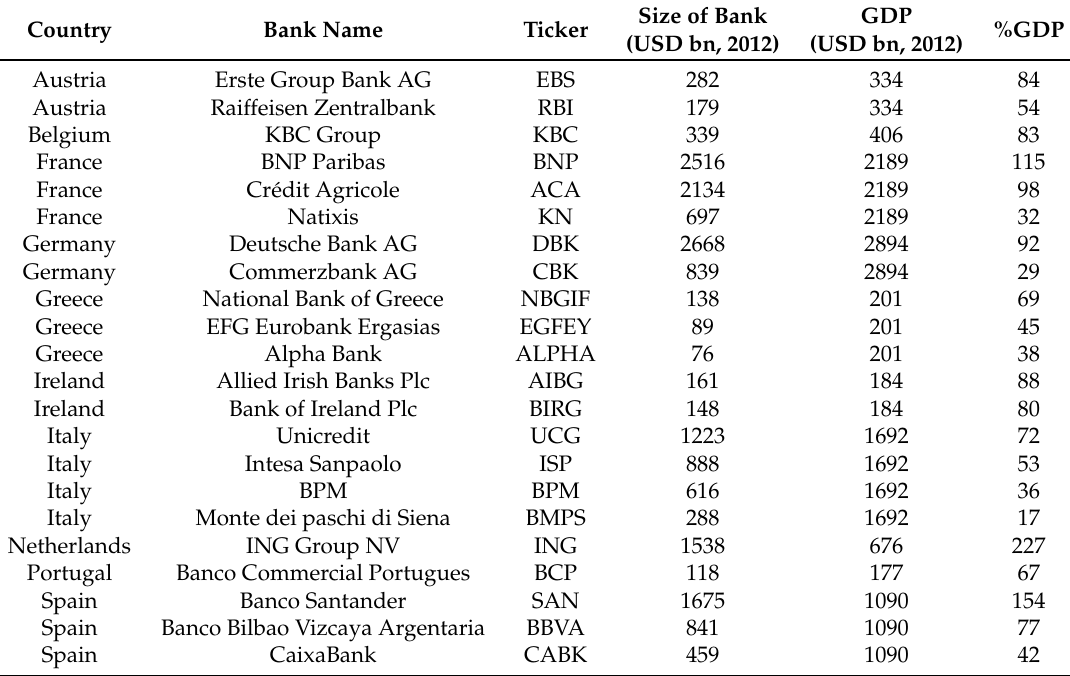
Table A1. Sample Banks. The table lists the larger banks in the Eurozone in 2012. Source: Bankscope. Country